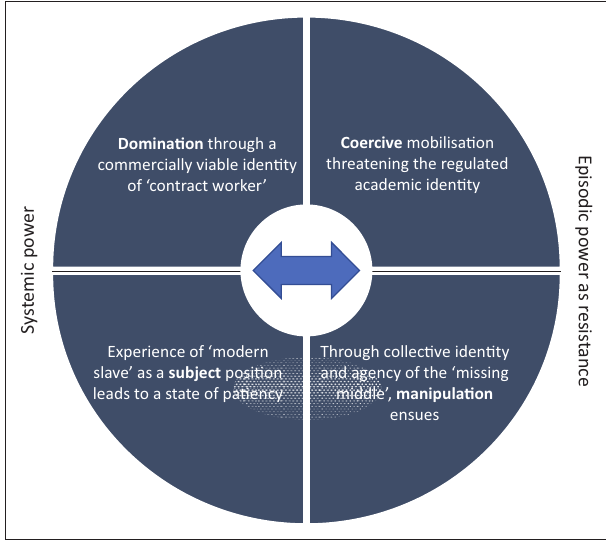
FIGURE 1: Theoretical contribution – Explaining the interplay between power, identity and resistance.